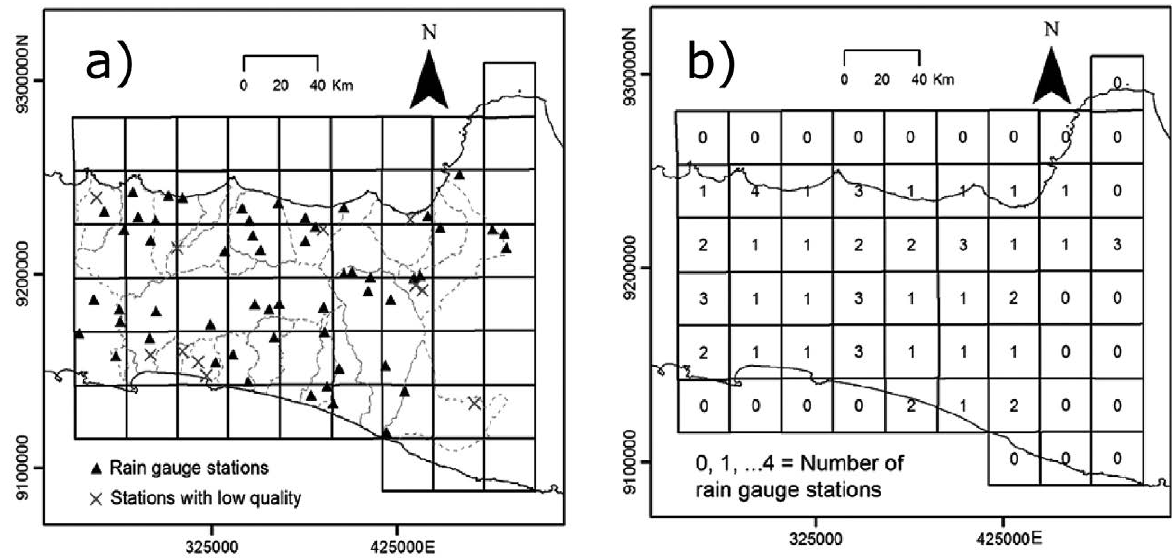
Fig. 6. Number of weather stations within each TRMM 0.25 sq. degree